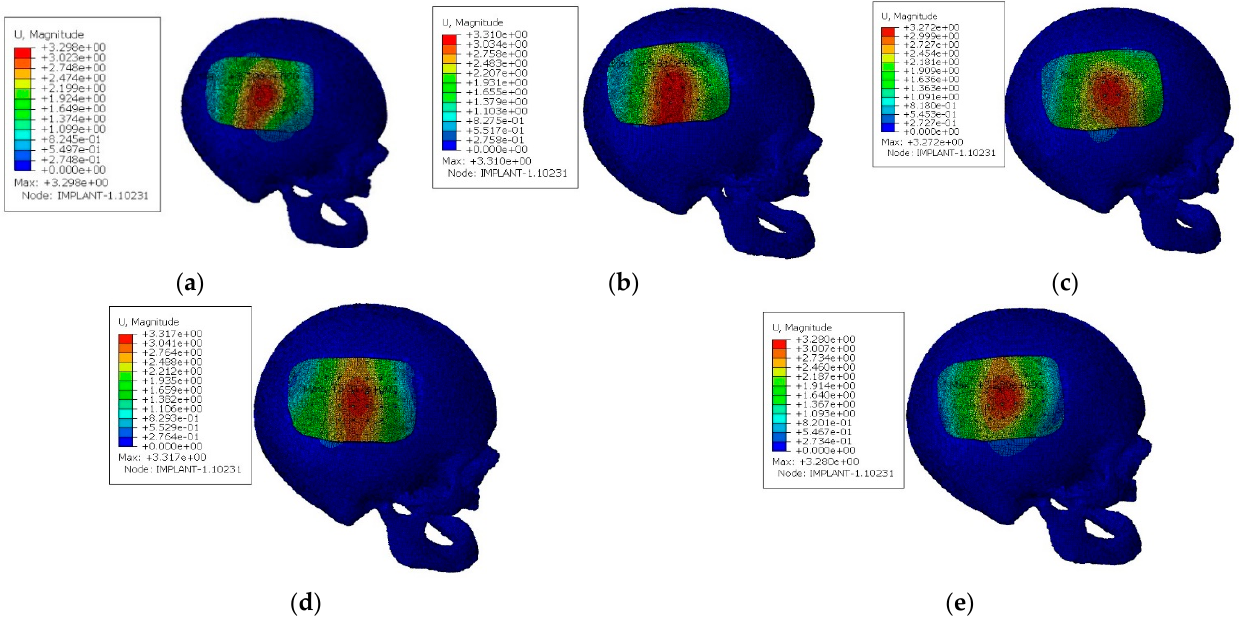
Figure 5. Displacement field for the models with different screws configuration [mm]: ( a ) configuration with five screws; ( b ) configuration with six screws; ( c ) configuration with seven screws; ( d ) configuration with eight screws; ( e ) configuration with nine screws.